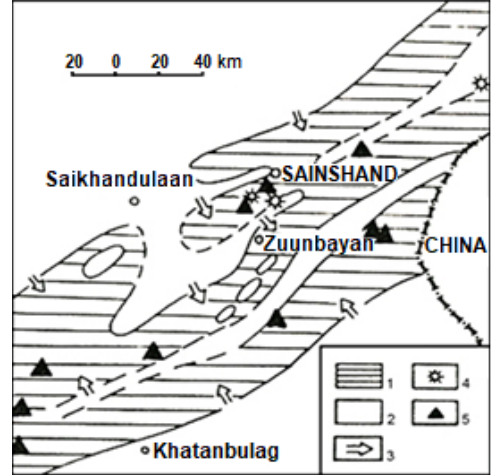
Fig. 3. Paleogeography of Zuunbayan basin (figure modified after Shuvalov et al., 1982) 1-Salty water depression (sediments). 2-Uplifted area. 3-Erosion trend. 4-Volcanoes. 5-Natural zeolite deposits.